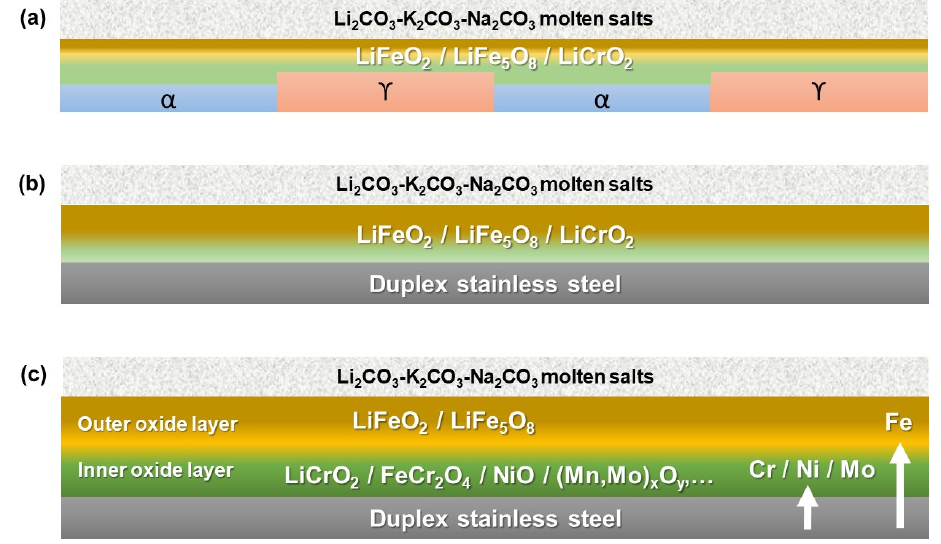
Figure 8. Scheme of the growth process of oxide scales in DS2205 and 2705 at: ( a ) the initial oxidation stage (after tens of hours) [28,29], ( b ) the increase in the oxidation time (until 300 h), and ( c ) the oxidation process at long-term (from 300 h to 1600 h).